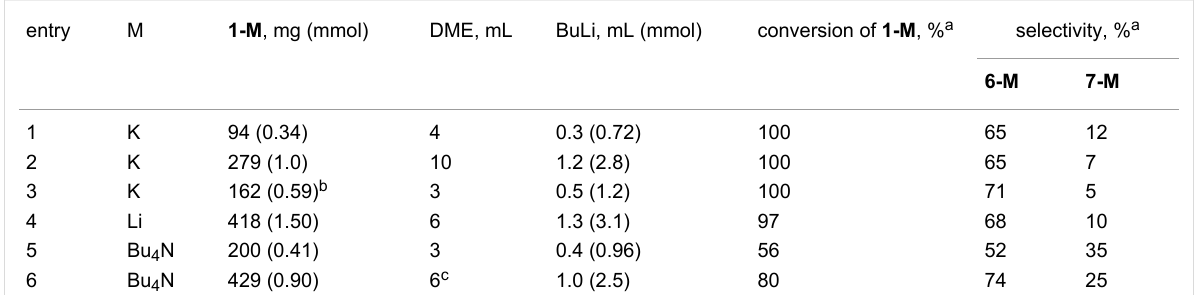
a from 19 F NMR data; b at 55–60 °C (bath) for 1 h; the reaction mixture contained K[2,5-Bu 2 C 6 F 3 BF 3 ] ( 8 ) (0.02 mmol, selectivity 3%) and K[2,4-Bu 2 C 6 F 3 BF 3 ] ( 9 ) (0.03 mmol, selectivity 5%); c in